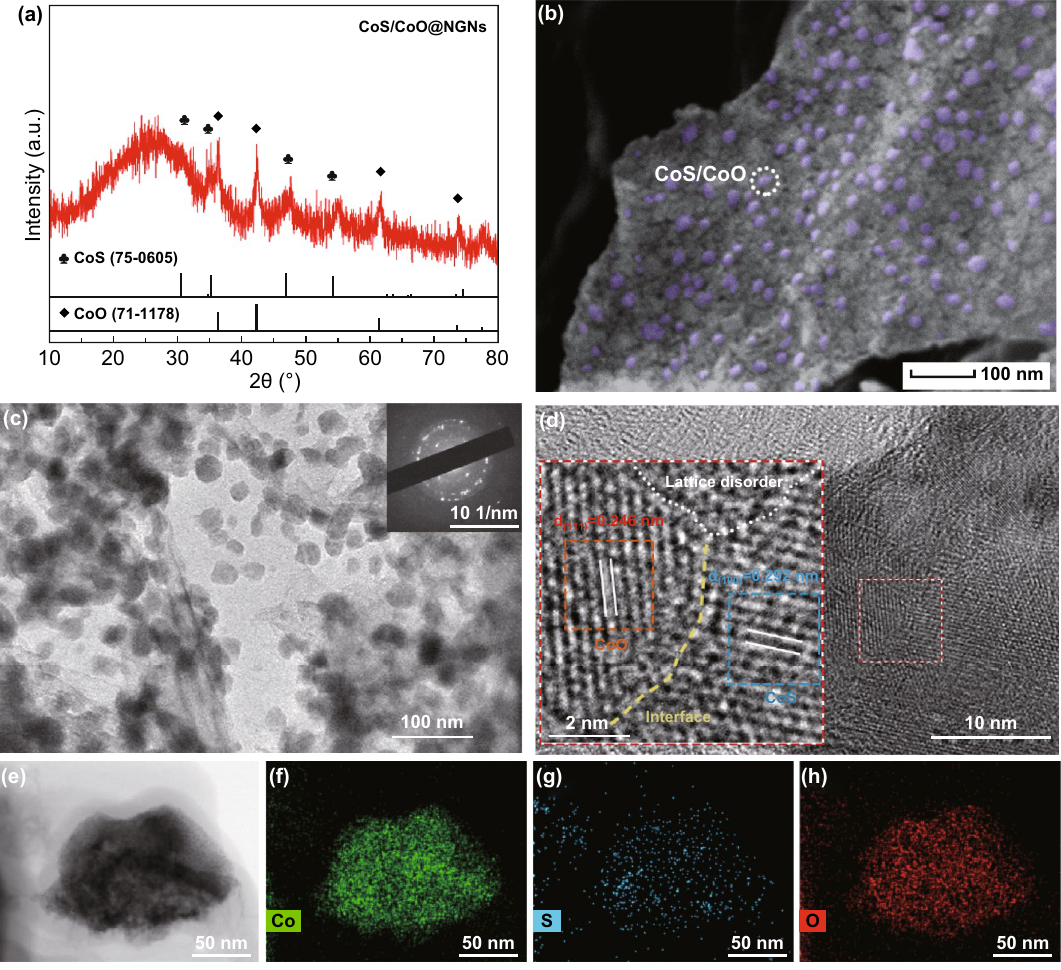
Fig. 2 a XRD pattern, b SEM, c TEM (inset: SAED pattern) and d HRTEM images of CoS/CoO@NGNs (inset: the magnified image of the selected area). e–h High-angle annular dark-field scanning TEM (HAADF-STEM) image and corresponding EDS elemental maps of Co, S